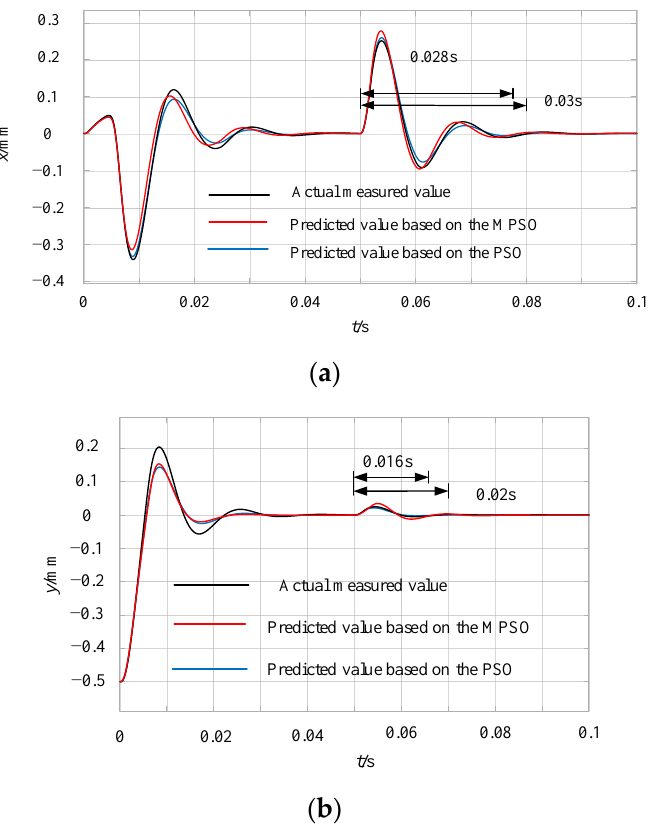
Figure 7. The displacement prediction curves of the rotor of the six-pole hybrid magnetic bearing when the rotor is disturbed: ( a ) in the x direction; ( b ) in the y direction.